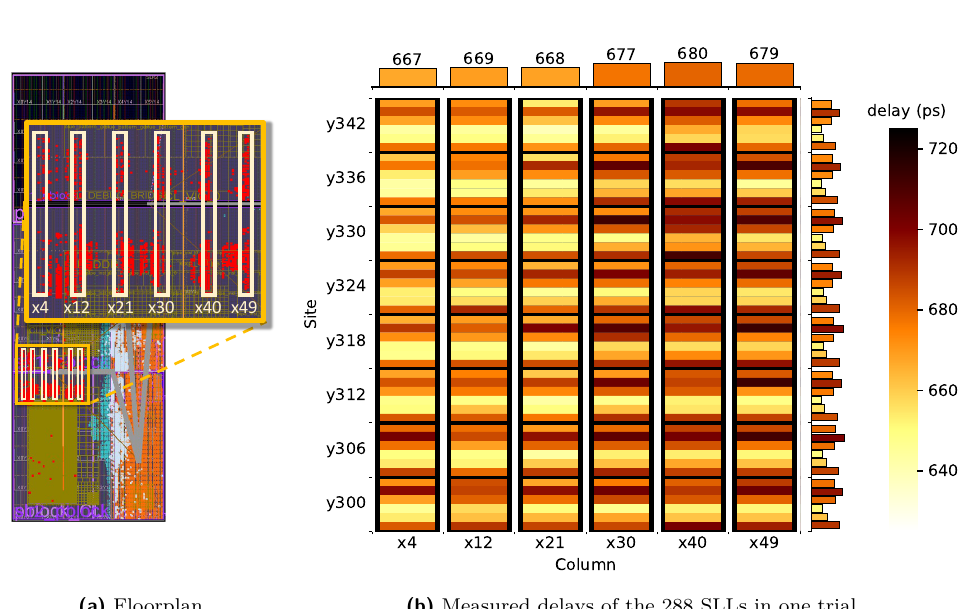
Figure 3: Floorplan shows the six circuit columns spanning SLR1 to SLR2 (a). Heatmap in (b) shows the measured delay of all 288 SLLs from a single trial, organized by column and site. The bars above show the average delay within each column, and at right show average delay of the 48 SLLs across all